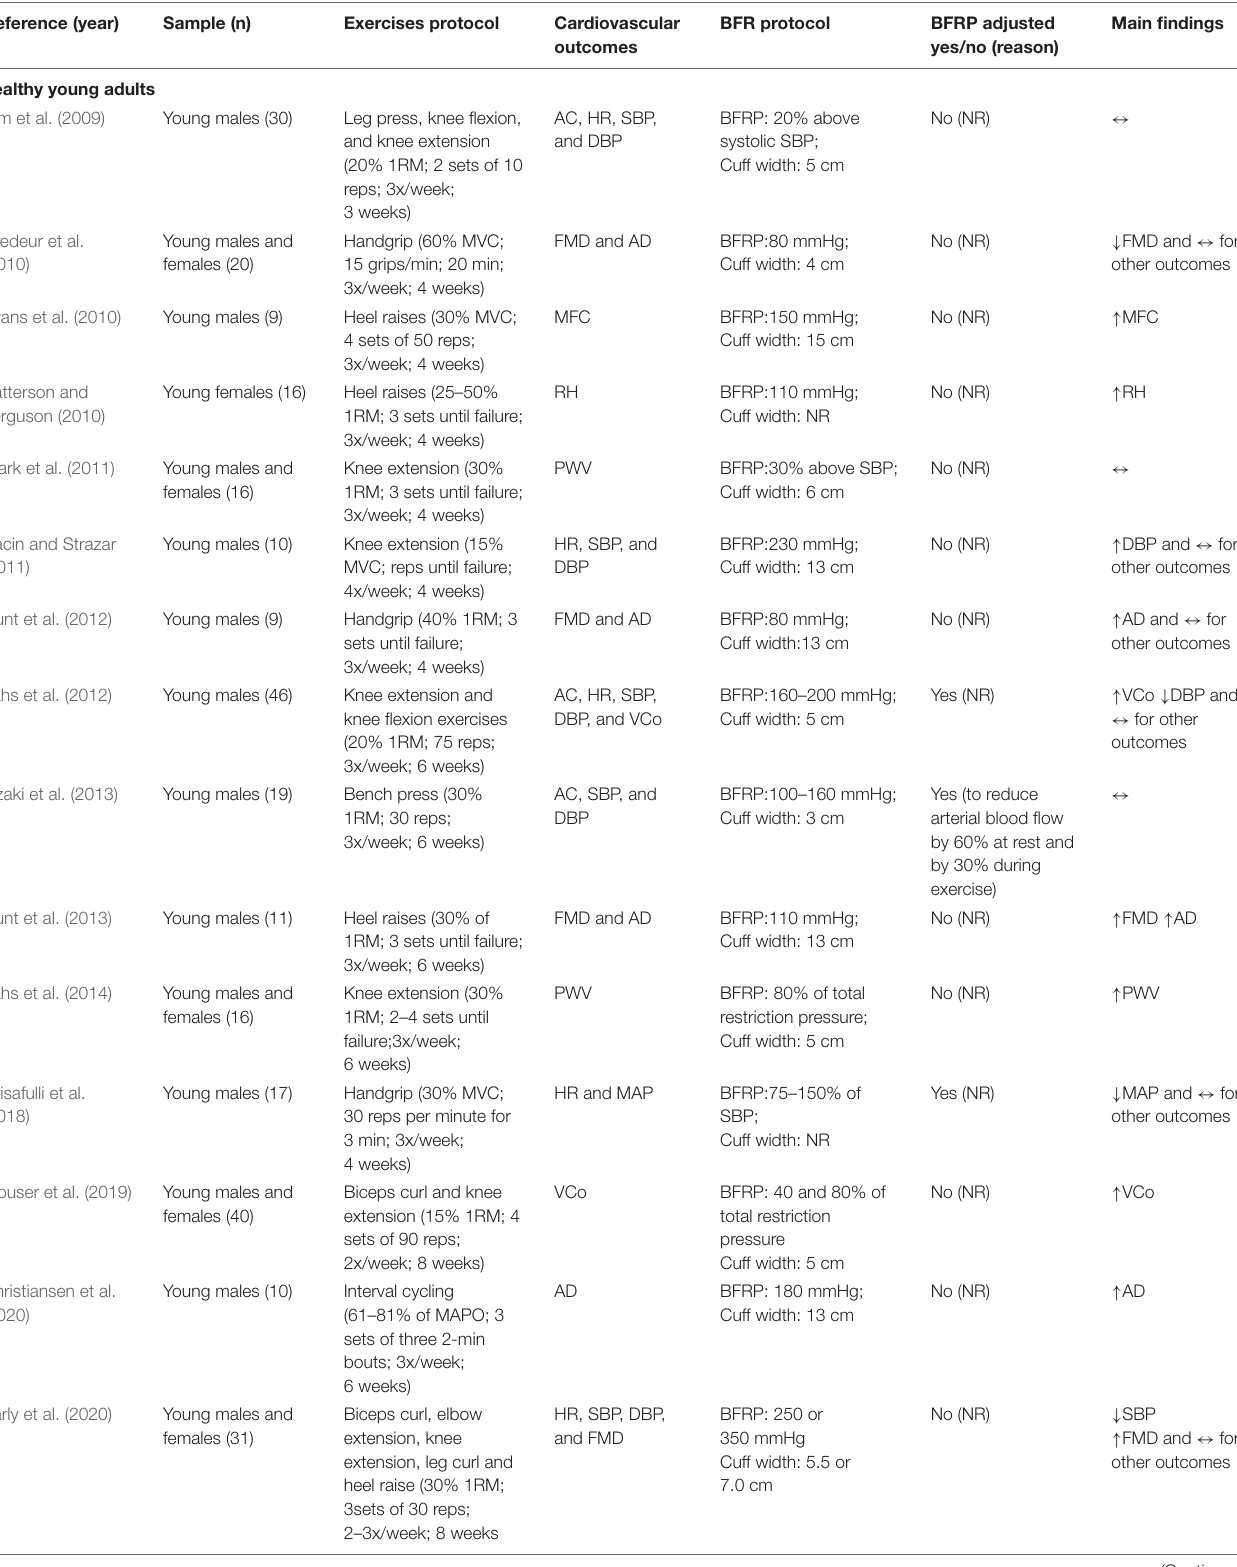
TABLE 2 | Characteristics of the studies that investigated the effects of BFR training on cardiovascular